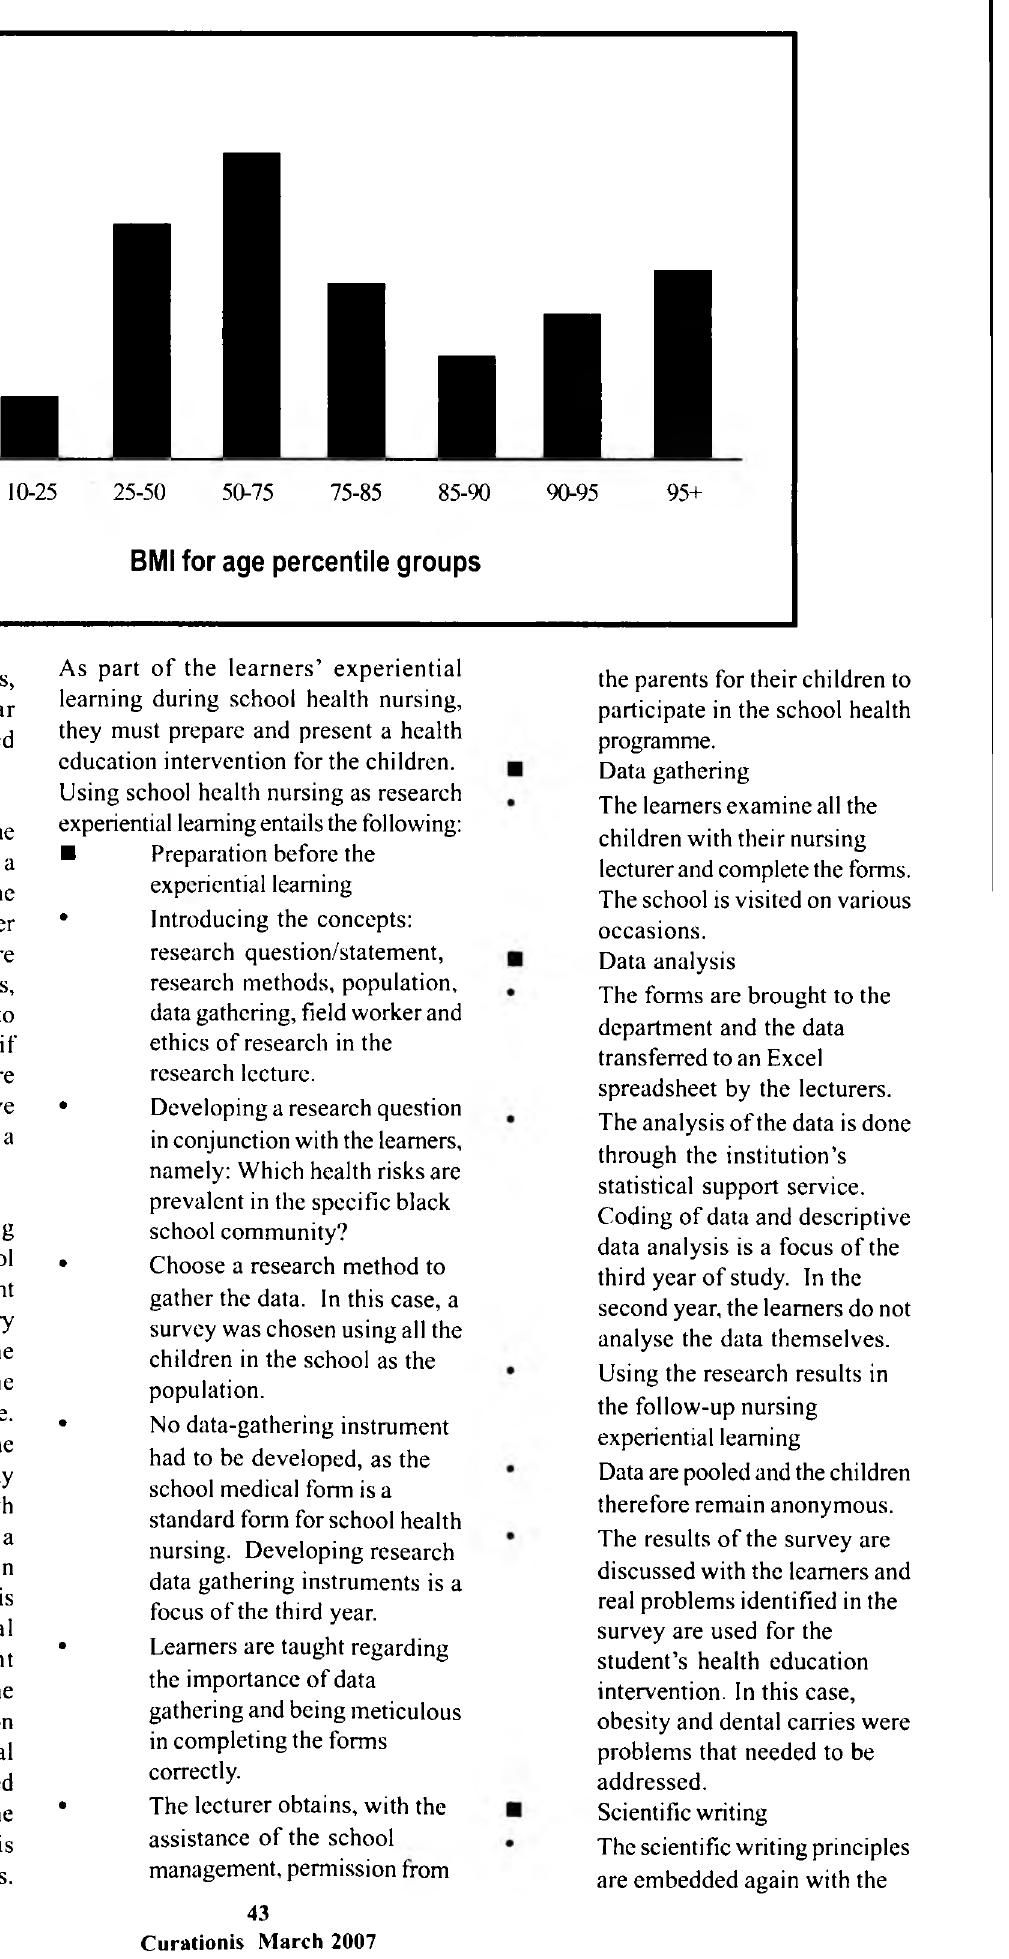
Table 1: BMI-for-age of school children